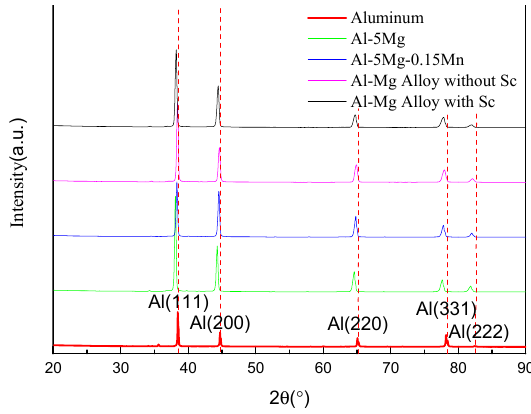
Figure 9. XRD patterns of alloys with different compositions. Table 2. Coefficients in the strength calculation formula [26,29,30]. Table 3. XRD lattice parameter detection and solid solubility calculation